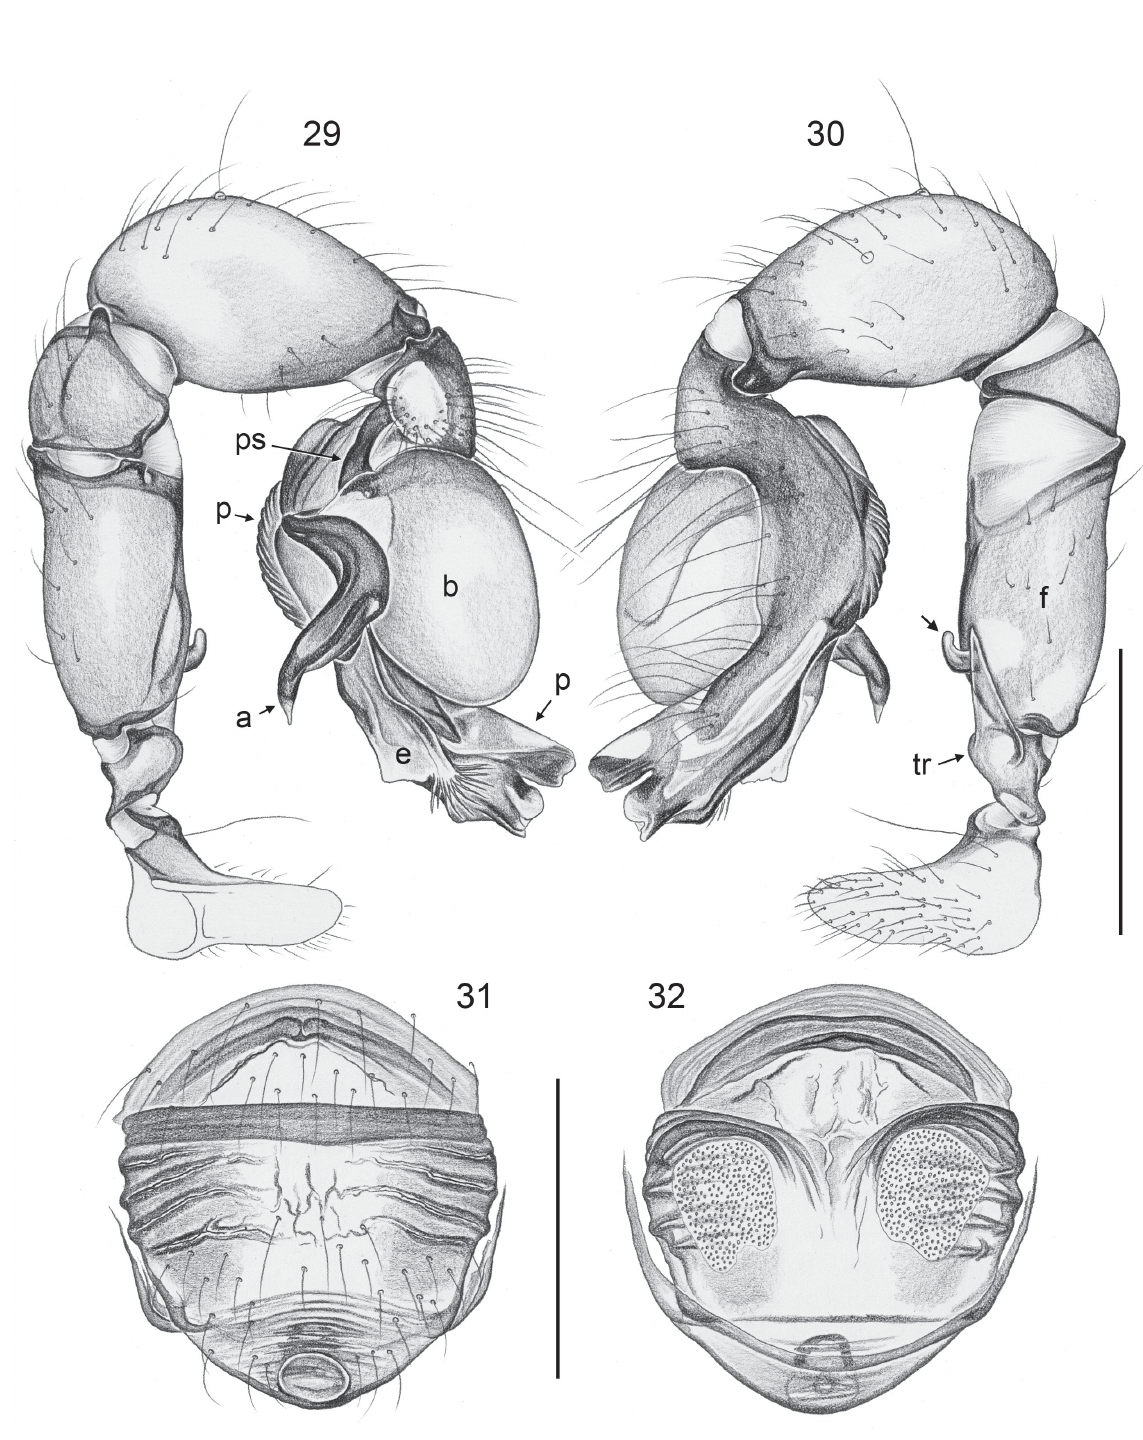
Figs 29–32. Panjange niah Huber, sp. nov. (ZFMK Ar 14579–80). 29–30 . Left male palp, prolateral and retrolateral views (arrow points at ventral femur apophysis). 31–32 . Cleared female genitalia, ventral and dorsal views. Abbreviations: a = appendix; b = genital bulb; e = embolus; f = femur; p = procursus; ps = proximal bulbal sclerite; tr = trochanter. Scale lines: 0.5